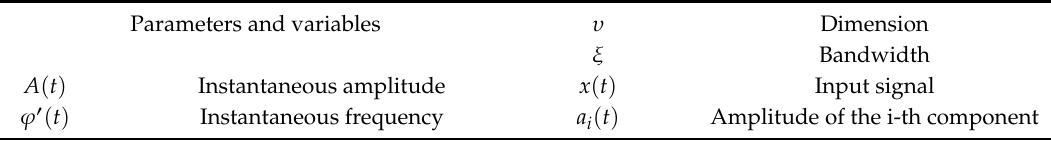
Figure 7. The predictions of different methods (B). Table 4. The comparison results of different methods (B).